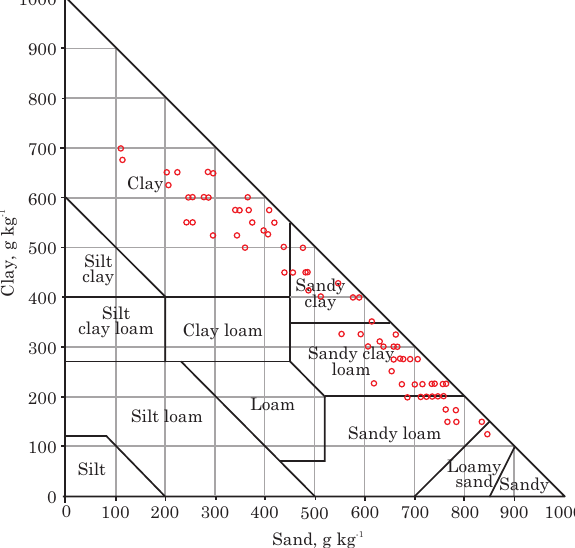
Figure 1. Textural classification of the soils used to evaluate the PTFs (n =